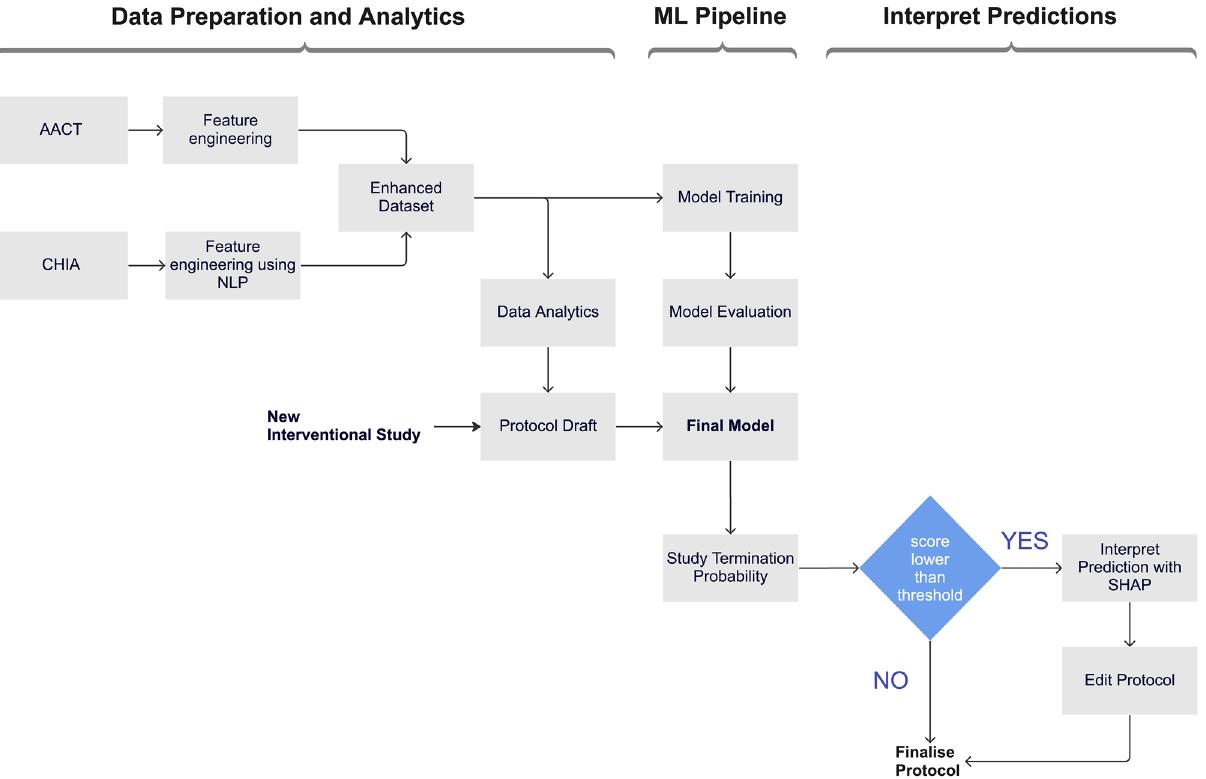
Figure 1. The proposed clinical trial design optimisation pipeline. This pipeline involves 3 stages: data preparation and analytics; machine learning (ML) pipeline and interpret predictions. This diagram